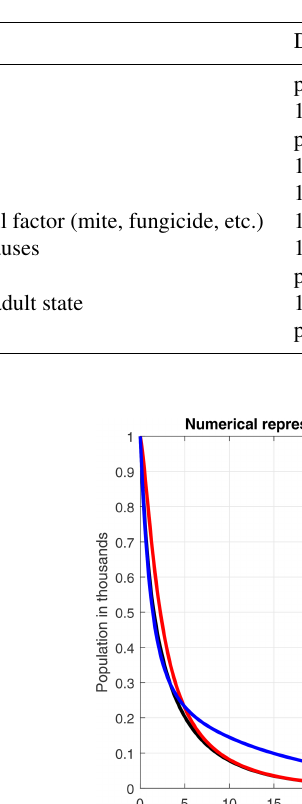
Table 2. Parameters involved in the model (Eq. 5): description and dimension.